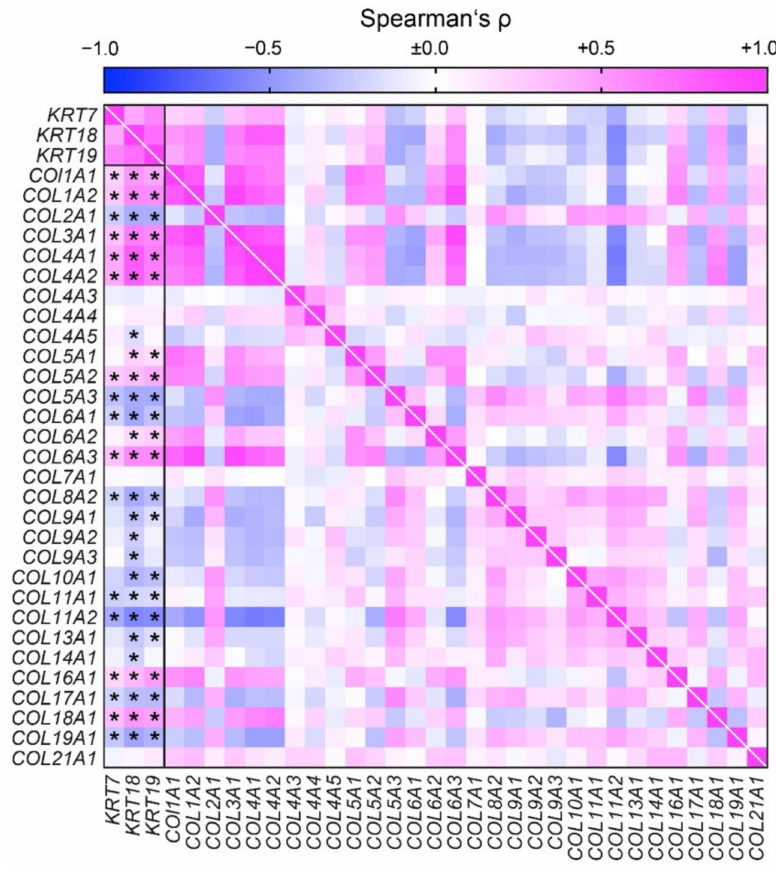
Figure 5. Tubulointerstitial transcriptome in association with tubular atrophy reveals distinct collagen signatures in kidney fibrosis associated with tubular injury markers. Association between mRNA expression of tubular atrophy markers ( KRT7 , KRT18 , and KRT19 ) and various collagens are shown by heatmap reflecting mean values of Spearman’s ρ of log 2 median centered intensities extracted from Nephroseq database (accession number GSE69438), asterisks (*) indicate p < 0.05. 3.6. Focal IF/TA Is Associated with Worse Long-Term Outcome in ANCA GN